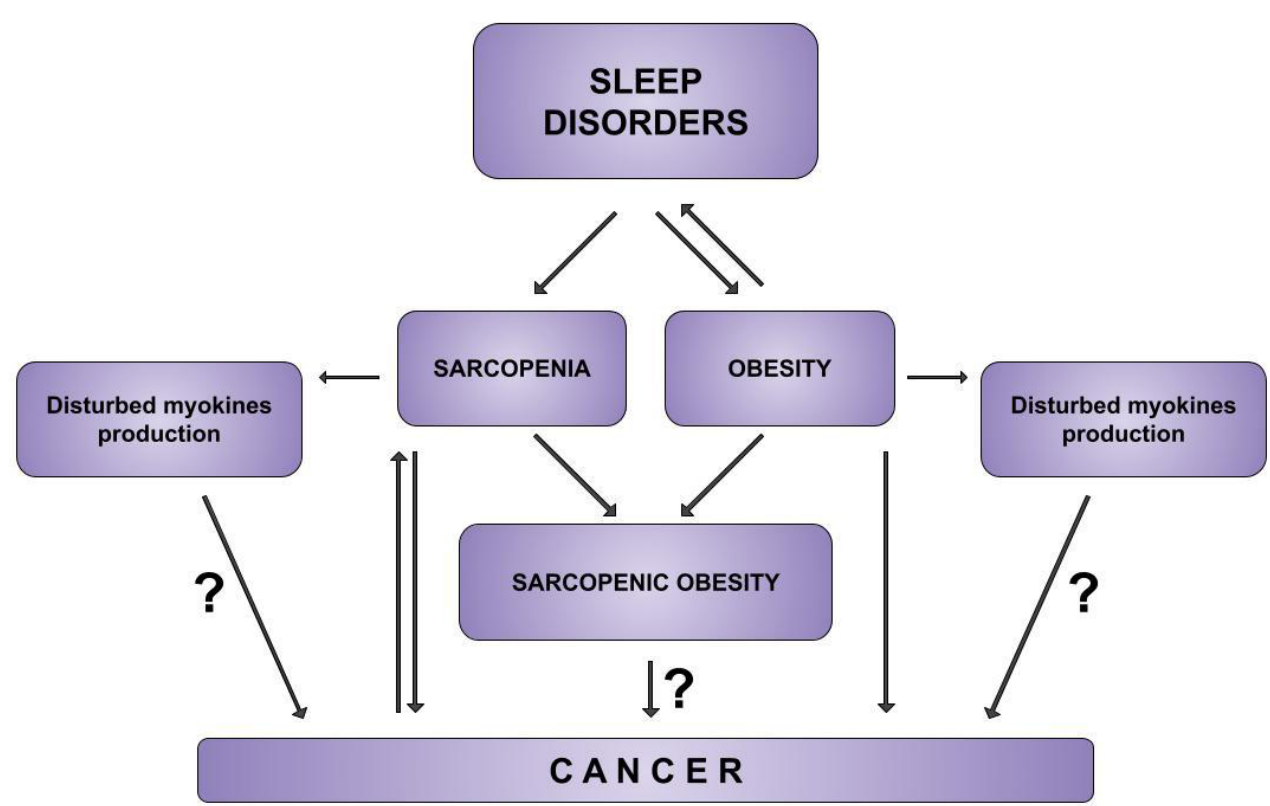
Figure 1. Possible association of sleep disorders, obesity and sarcopenia with cancerogenesis.